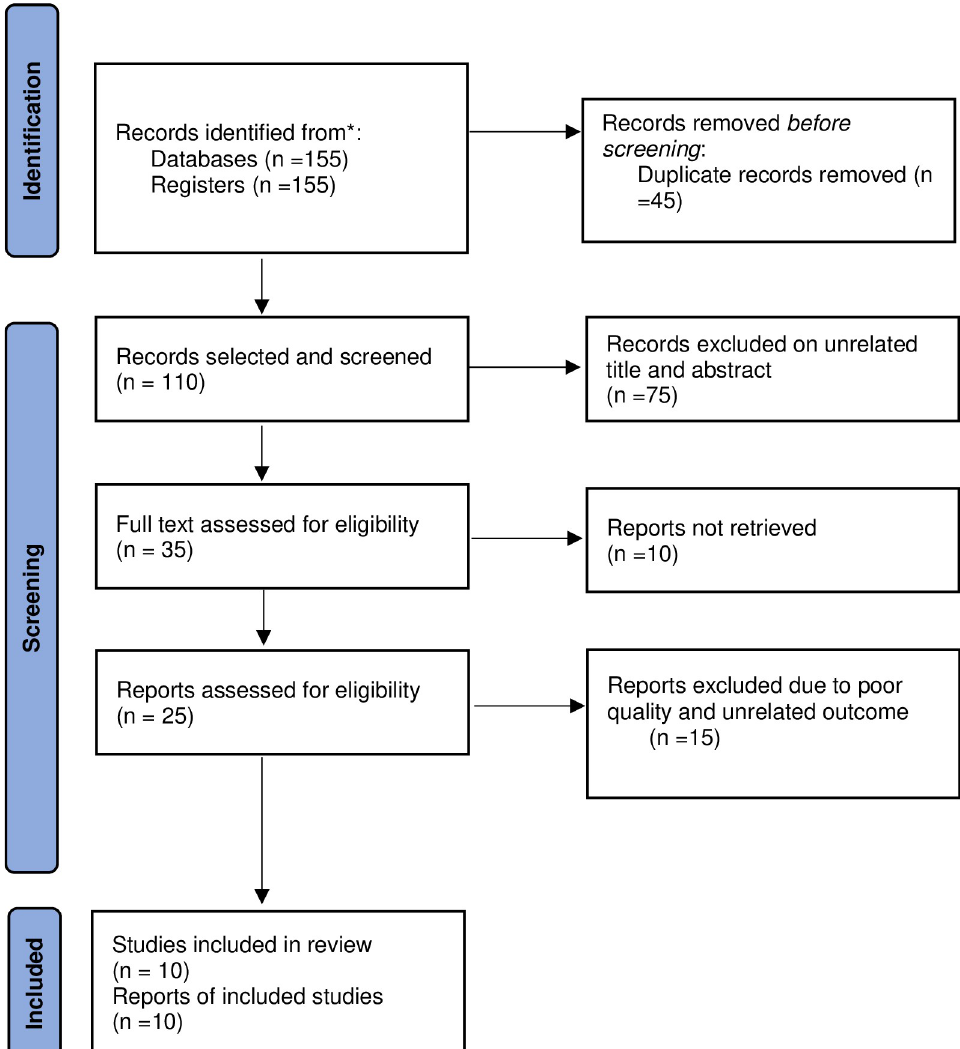
Fig 1. PRISMA flowchart for COVID-19 vaccine acceptance in Nigeria study search